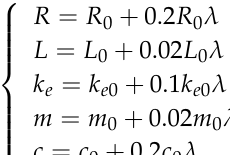
Figure 8. Simulation results of the proposed controller with the different parameter ω n , when the parameter ω c = 100: ( a ) Position; and ( b ) Position